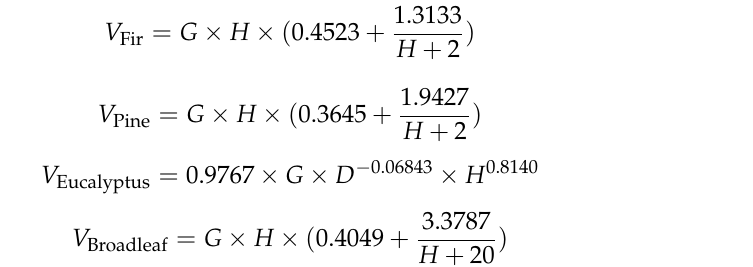
Table 1. Summary statistics of the field plot data. CV is the coefficient of variation.